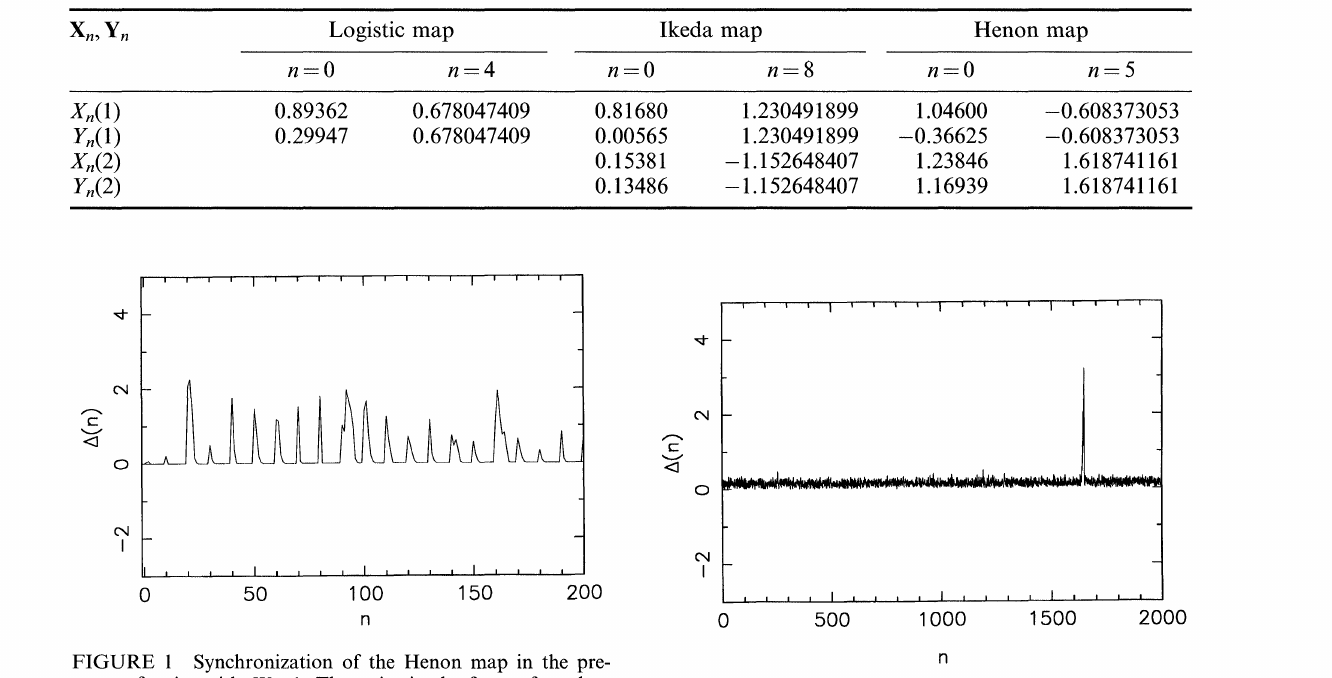
FIGURE 2 Synchronization of the Henon map in the pre- sence of noise with W--0.1. The noise is added to X,(1), X(2), Yn(1) and Y,(2) at every discrete time